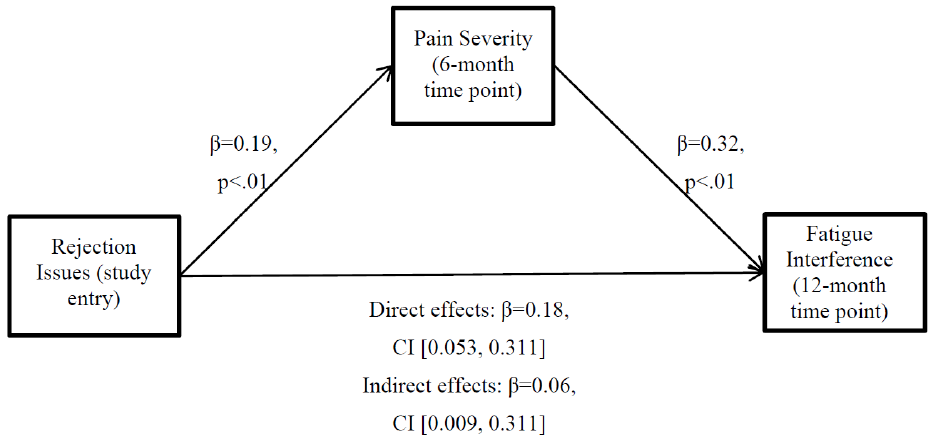
Figure 1. Path diagram of mediation model. Pain severity partially mediates the relationship between rejection issues and subsequent fatigue interference.